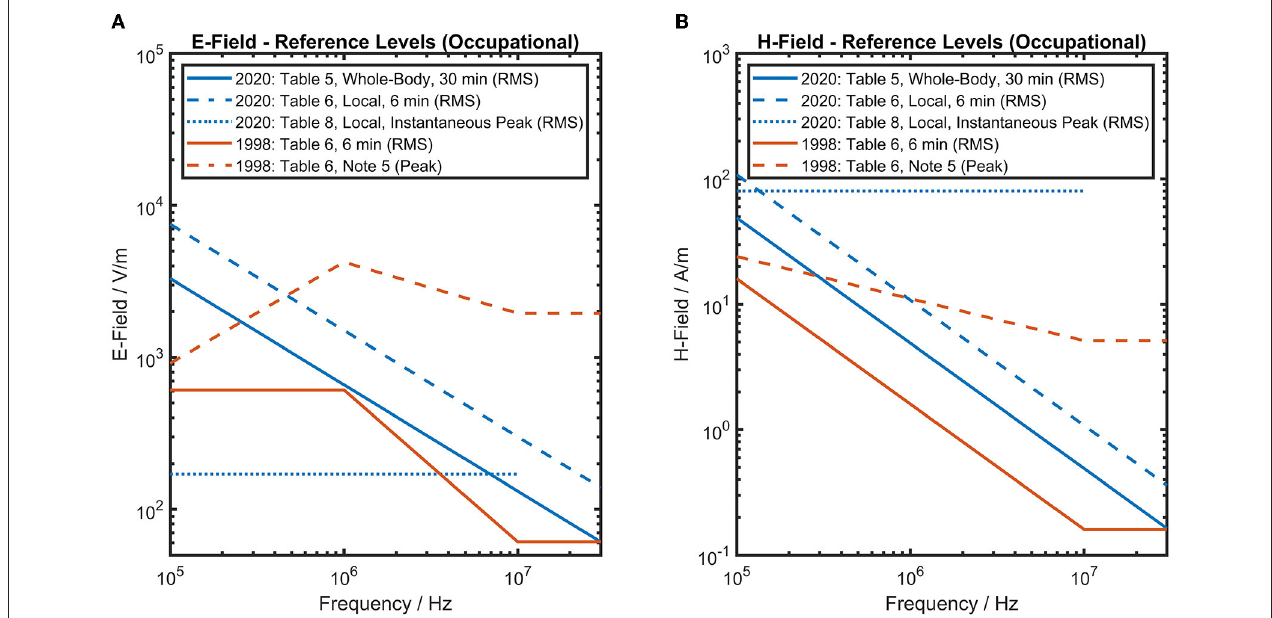
FIGURE 1 | ICNIRP’s 1998 and 2020 (1, 7) reference levels for occupational exposure are shown for E-field strength (A) and H-field strength (B) between 100kHz and 30 MHz. Reference levels of ICNIRP 2020 (1) have increased. Since E- & H-field reference levels must both be considered, it is necessary to check compliance with six different values for frequencies between 100kHz and 10 MHz—which is not ideal from a practical